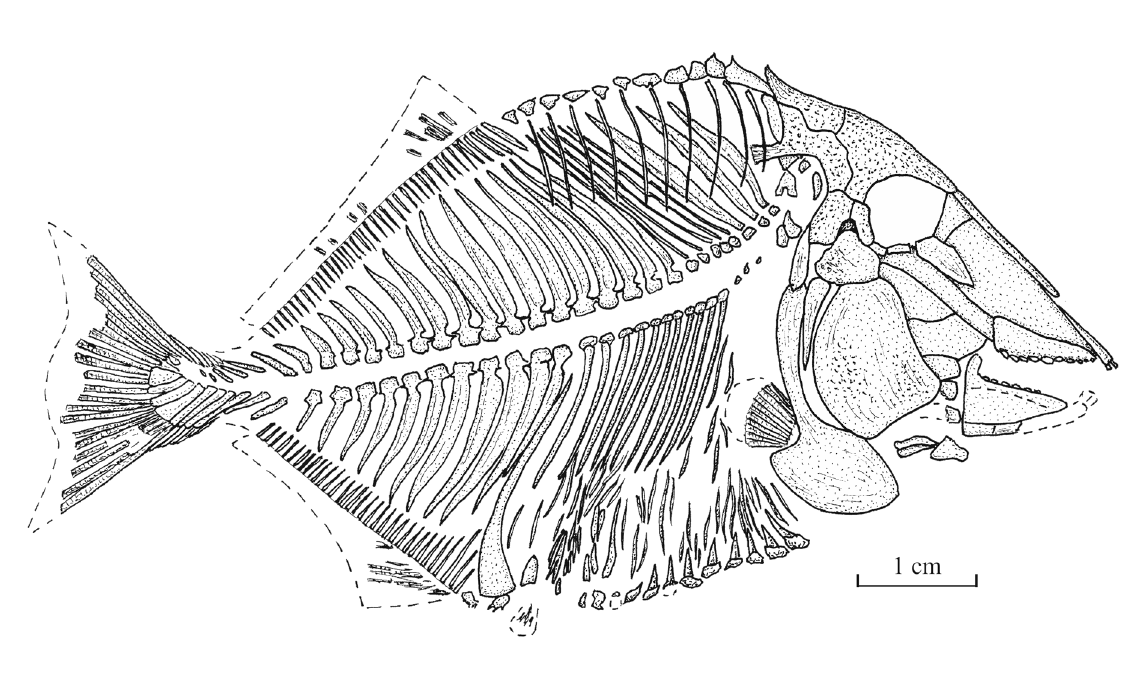
Fig. 2. Libanopycnodus wenzi gen. et sp. nov., holotype, reconstruction (CLC